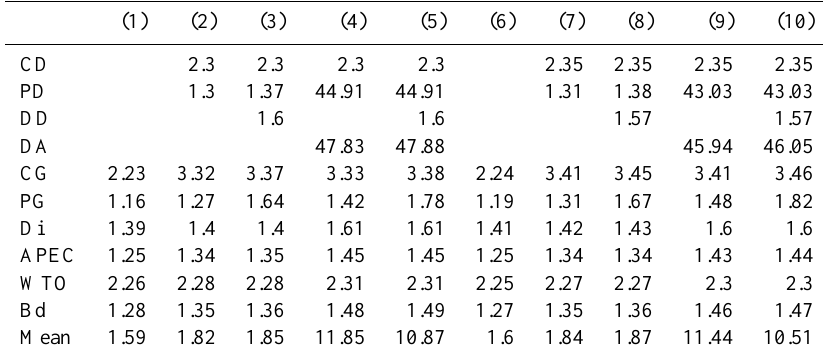
Table 4. Variance inflation factors of variables.